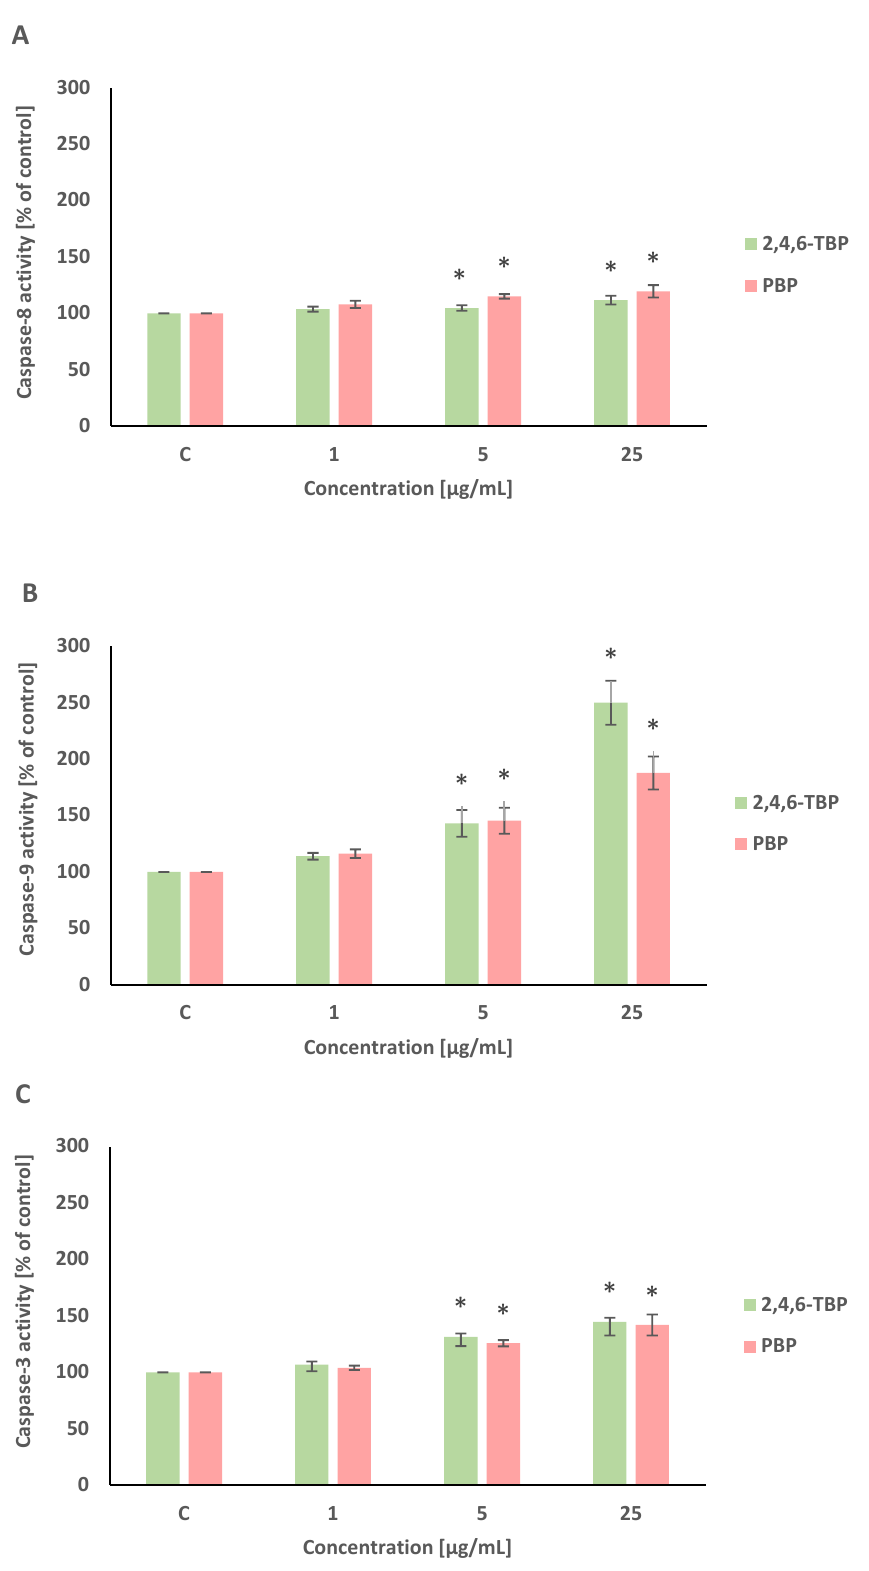
Figure 4. Changes in the activity of caspase-8 ( A ), -9 ( B ), and -3 ( C ) in human PBMCs incubated with 2,4,6-TBP and PBP in concentrations ranging from 1 to 25 µg/mL for 24 h. Means ± SDs were calculated from four individual experiments (four blood donors). Results were statistically different from negative control at * p < 0.05. Statistical analysis was conducted using one-way ANOVA and a posteriori Tukey test.